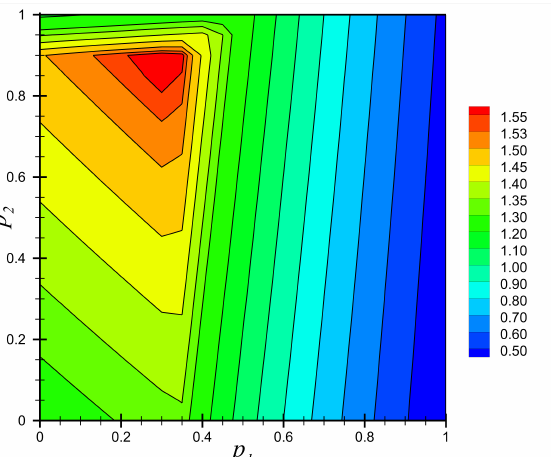
Figure 12. Contour plot of the field of minimum factor of safety, η min ( p 1 , p 2 ) , for the full range of material parameters p 1 and p 2 for Example 3.